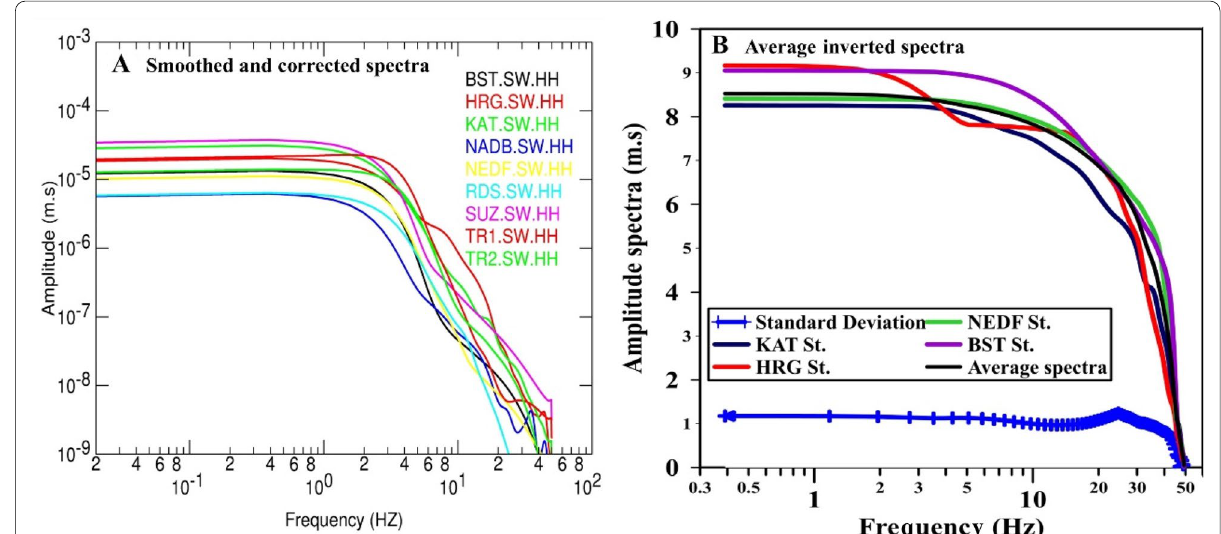
Fig. 7 A The corrected and smoothed waveform at each station of the June 16, 2020 event. B The inverted Fourier spectra with their average spectra and standard error